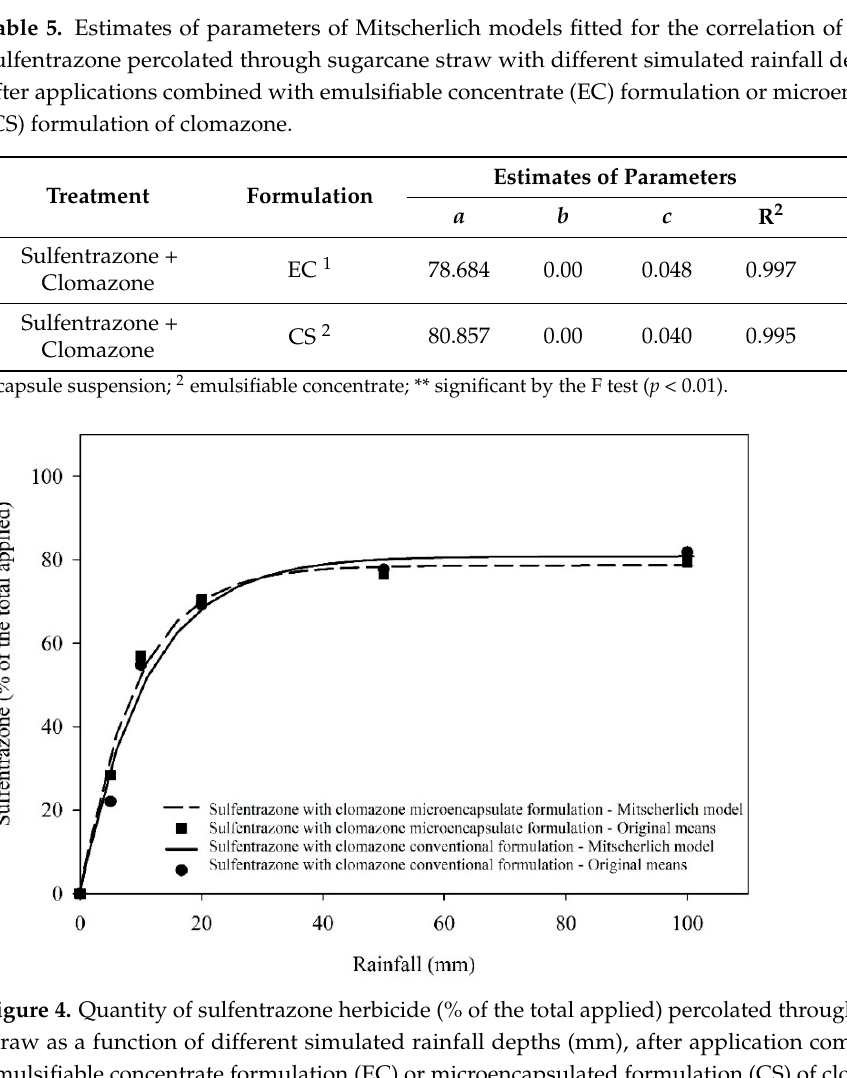
when it was applied in combination with the microencapsulated formulation of